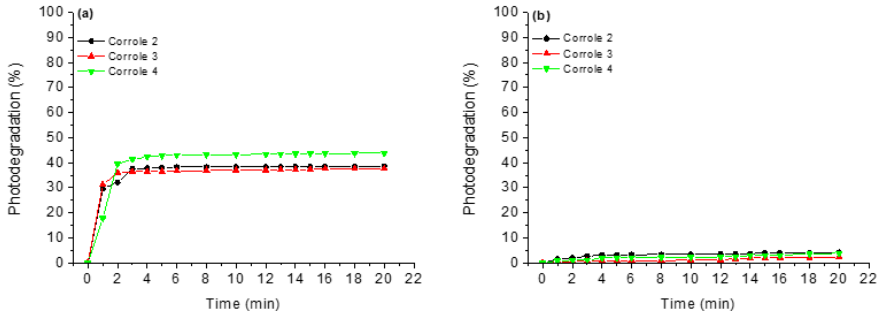
Figure 4. Photostability assays under white-light LED irradiation (fluence rate of 50 mW cm −2 and a total light dosage of 90 J cm −2 ) for a period of 20 min, where ( a ) DMSO and ( b ) DMSO(5%)/Tris-HCl pH 7.4 mixture buffered solution.